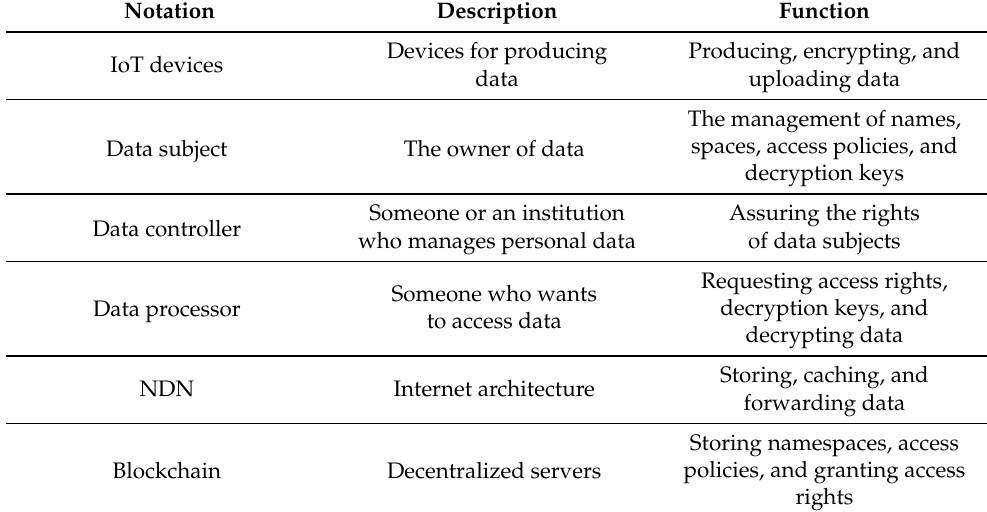
Table 2. Notation of entries in NACDA